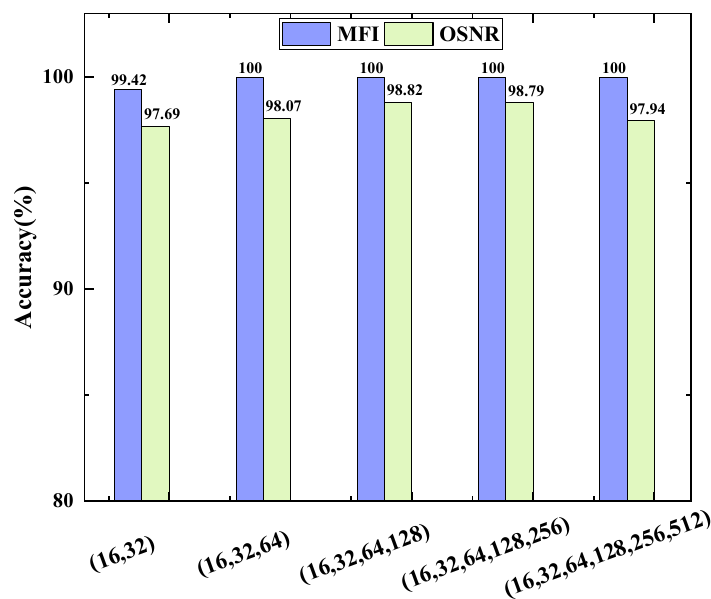
Figure 10. MFI and OSNR accuracies for different numbers of convolutional layers.